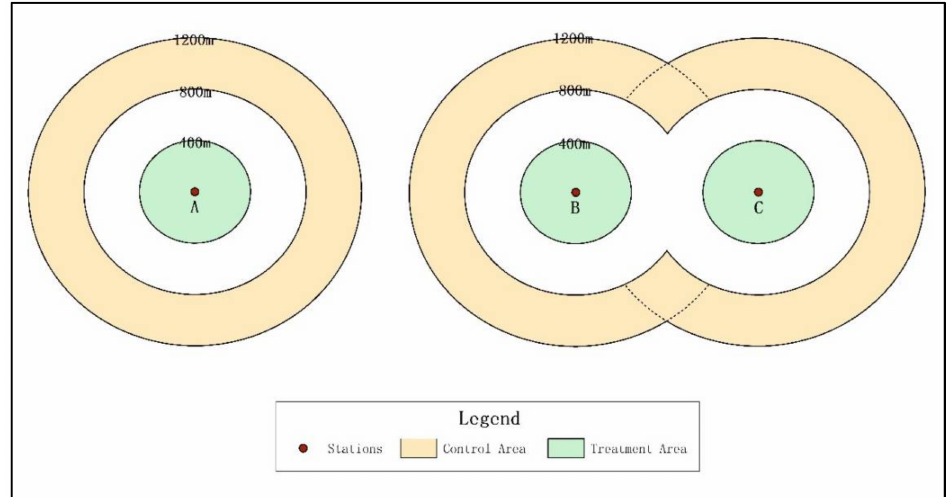
Figure 4. The treatment areas and control areas around new subway